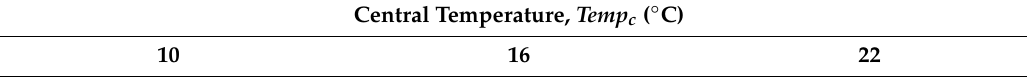
Table 4. Top five parameters influencing MaxH i . Includes only epidemic simulations, main e ff ects only.